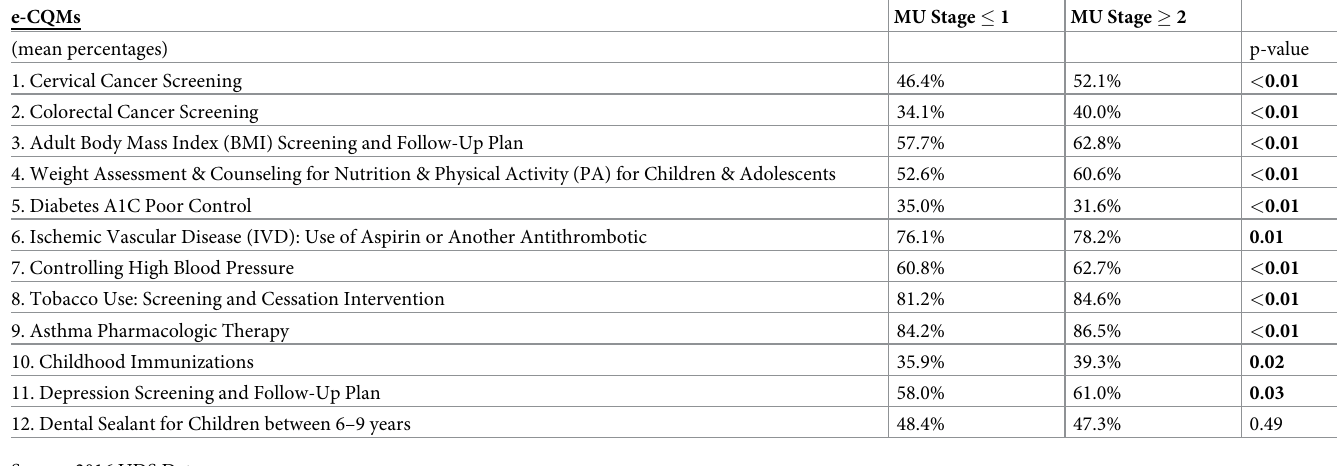
Table 2. Electronic Clinical Quality Measure (e-CQMs) performance by Meaningful Use (MU) attestation. e-CQMs